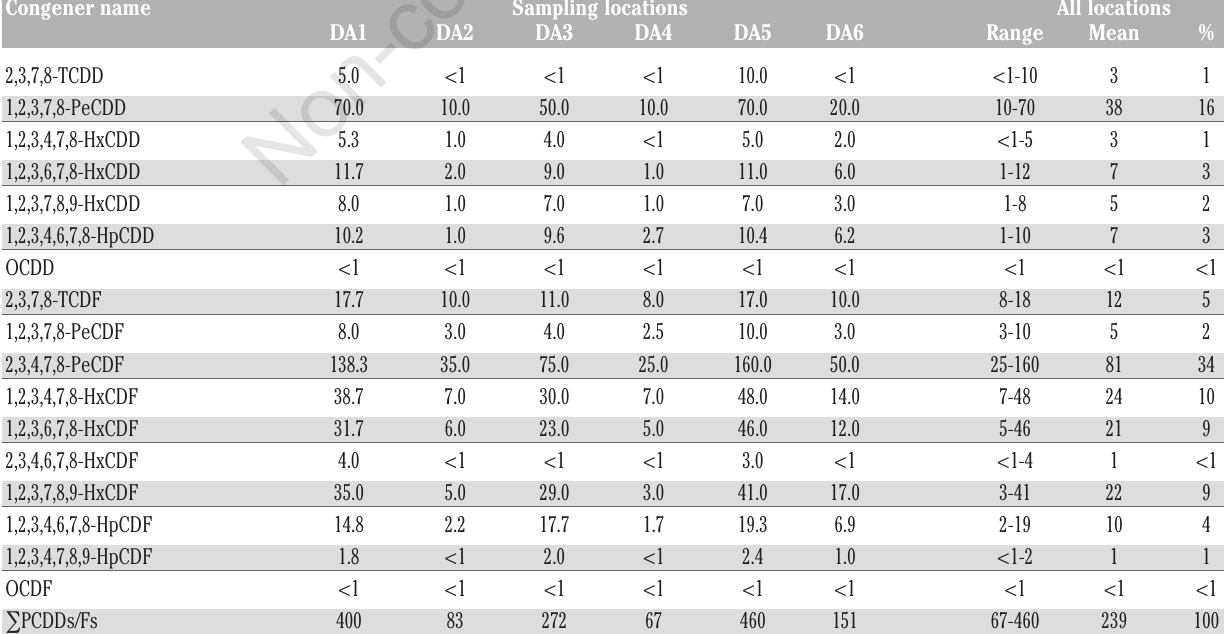
Table 2. Toxic equivalent quantities (TEQ) of polychlorinated dibenzo -p- dioxins/dibenzo -p- furans (fg I-TEQ m -3 ) in ambient air (PM in Delhi. Congener